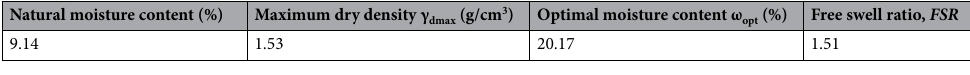
Natural moisture content